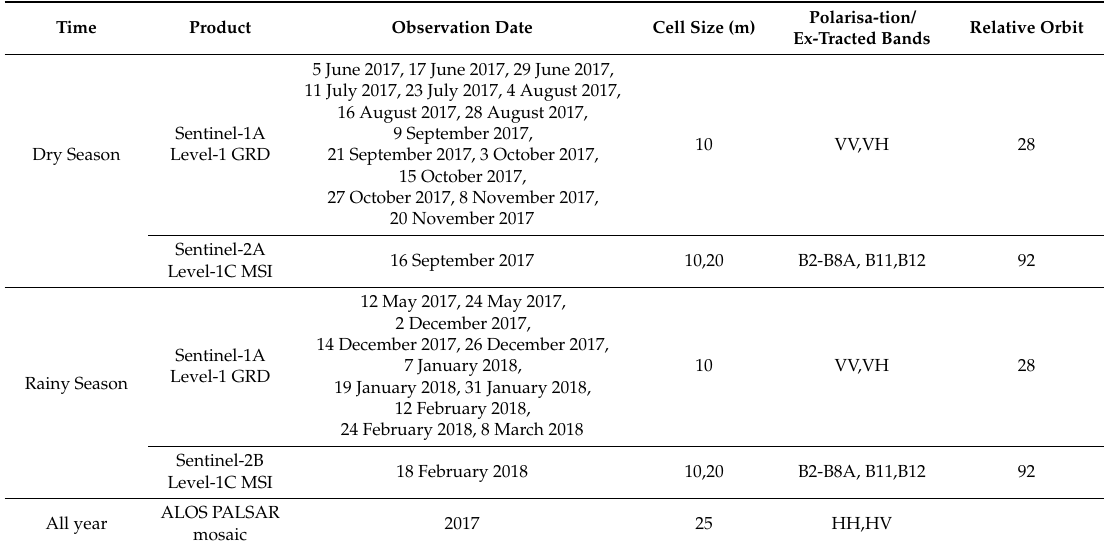
Table 2. List of images acquired for the study, divided into dry season, rainy season, and all year